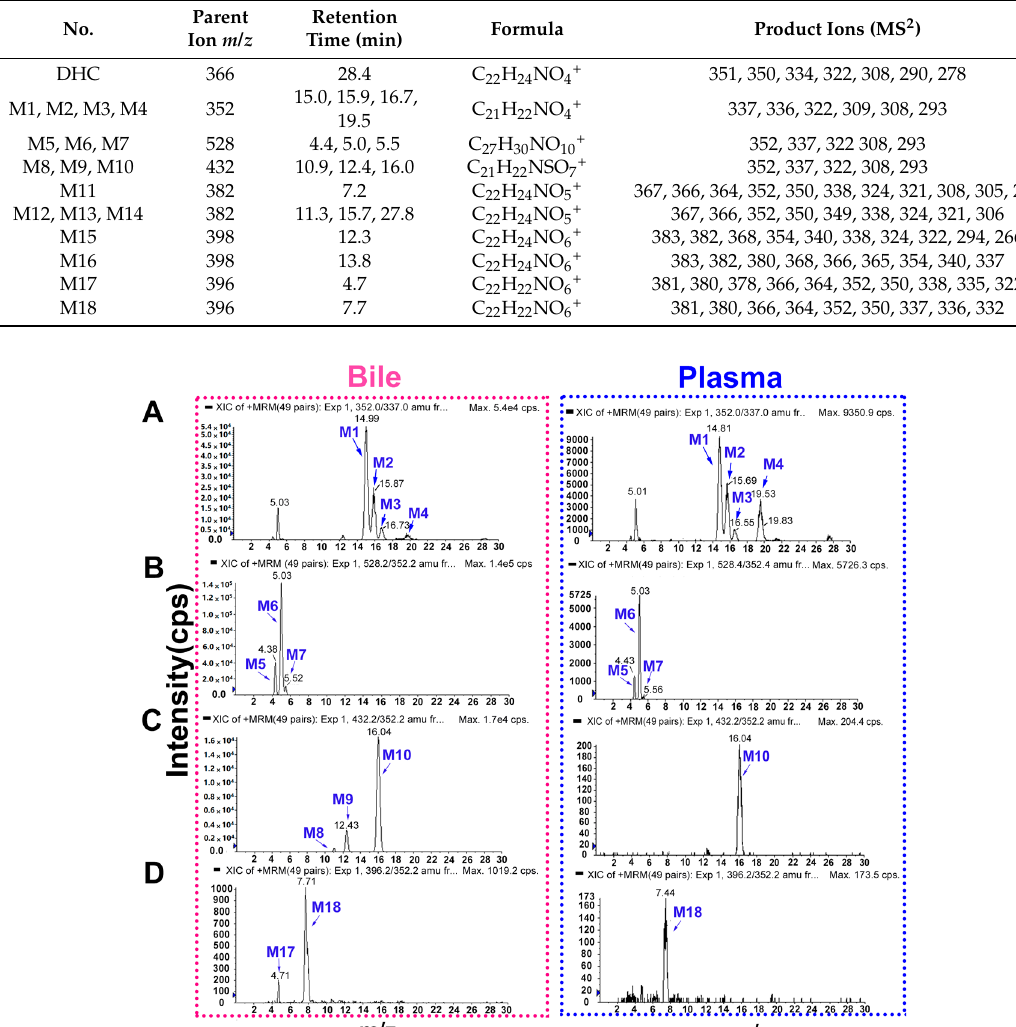
Figure 2. The extracted ion chromatograms (XICs) of the dehydrocorydaline (DHC) metabolites in bile and plasma. ( A ) O -demethylated metabolites (M1–M4); ( B ) O -demethylated metabolites followed by glucuronidation (M5–M7); ( C ) O -demethylated metabolites followed by sulfation (M8–M10); and ( D ) metabolites due to di-hydroxylation and dehydrogenation (M17 and M18).